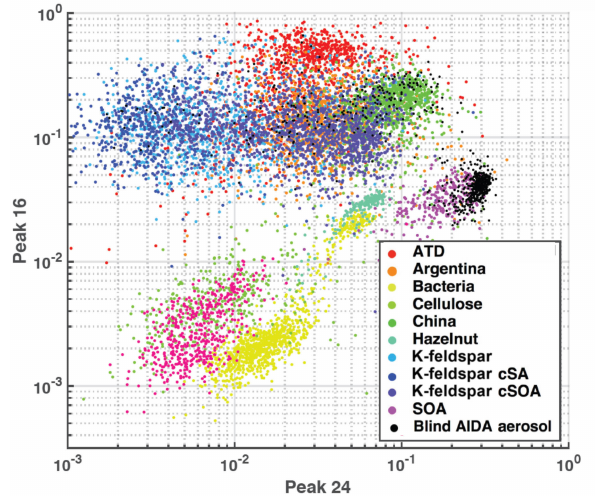
Figure 1. Aerosol training data plotted as feature area 16 (O − ) ver- sus area 24 (C − ). Axes represent peak areas normalized to total 2 signal obtained from PALMS (i.e., 1 = 100% of signal). This illus- trates simple two-dimensional clustering of aerosols from the train- ing data set by type. Co-plotted are ∼ 500 randomly drawn spectra from the AIDA blind experiment, which were known to be a subset of the training data